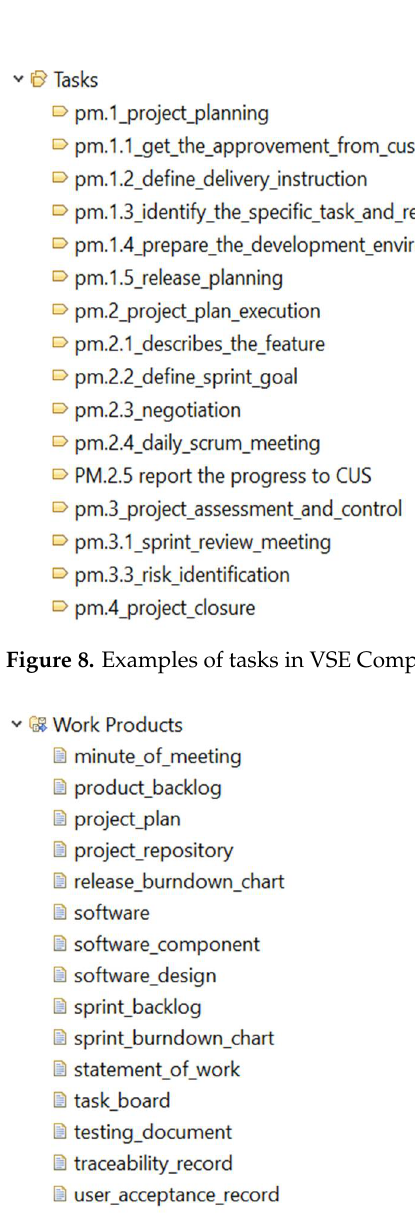
Figure 10. Structure of capability patterns in the EPF.